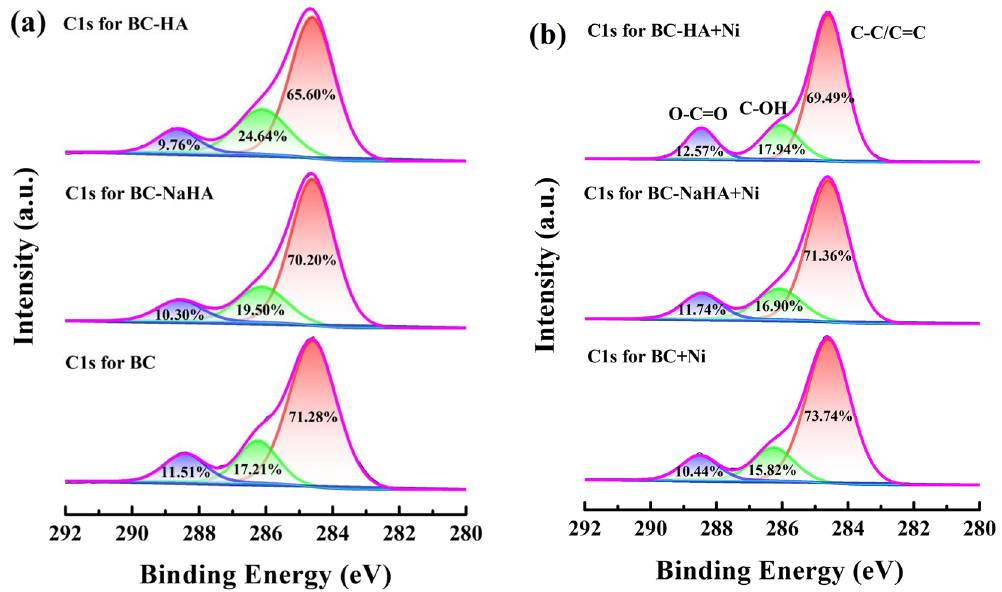
Figure 10. C1s high-resolution spectra ( a ) BC, BC-NaHA and BC-HA; ( b ) BC + Ni, BC-NaHA + Ni, BC-HA + Ni.